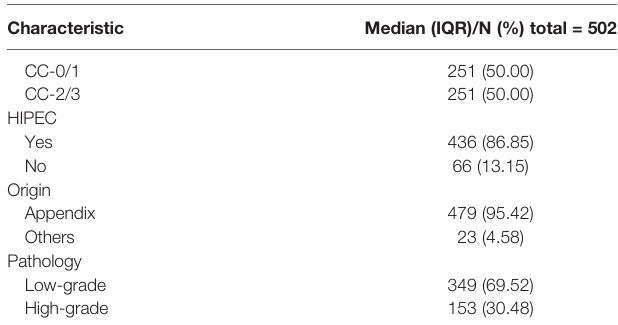
TABLE 1 | Demographic, clinical, and US characteristics of